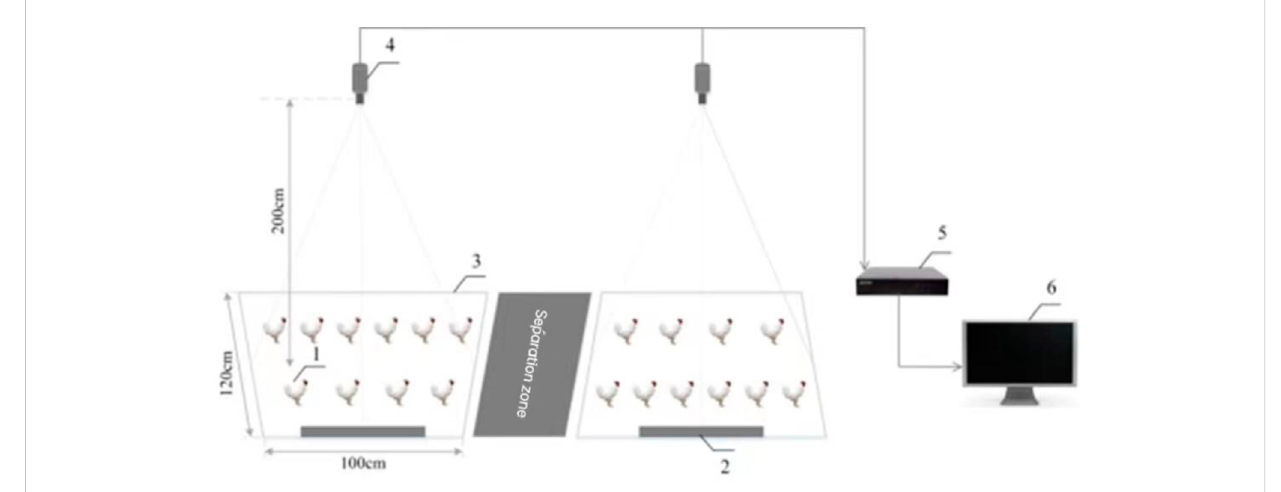
FIGURE 1 Structure diagram of the experimental fi